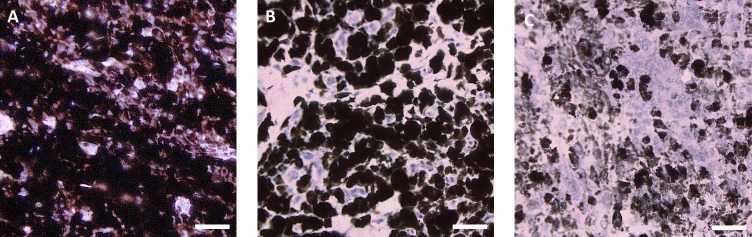
Histologically differing regions identified in hematoxylin-eosin-stained skin melanoma of a 10-week-old MeLiM.(A) Growing melanoma tissue (GMT), (B) melanoma tissue with early spontaneous regression (ESR), and (C) melanoma tissue with late spontaneous regression (LSR) (scale bar = 20 μm).